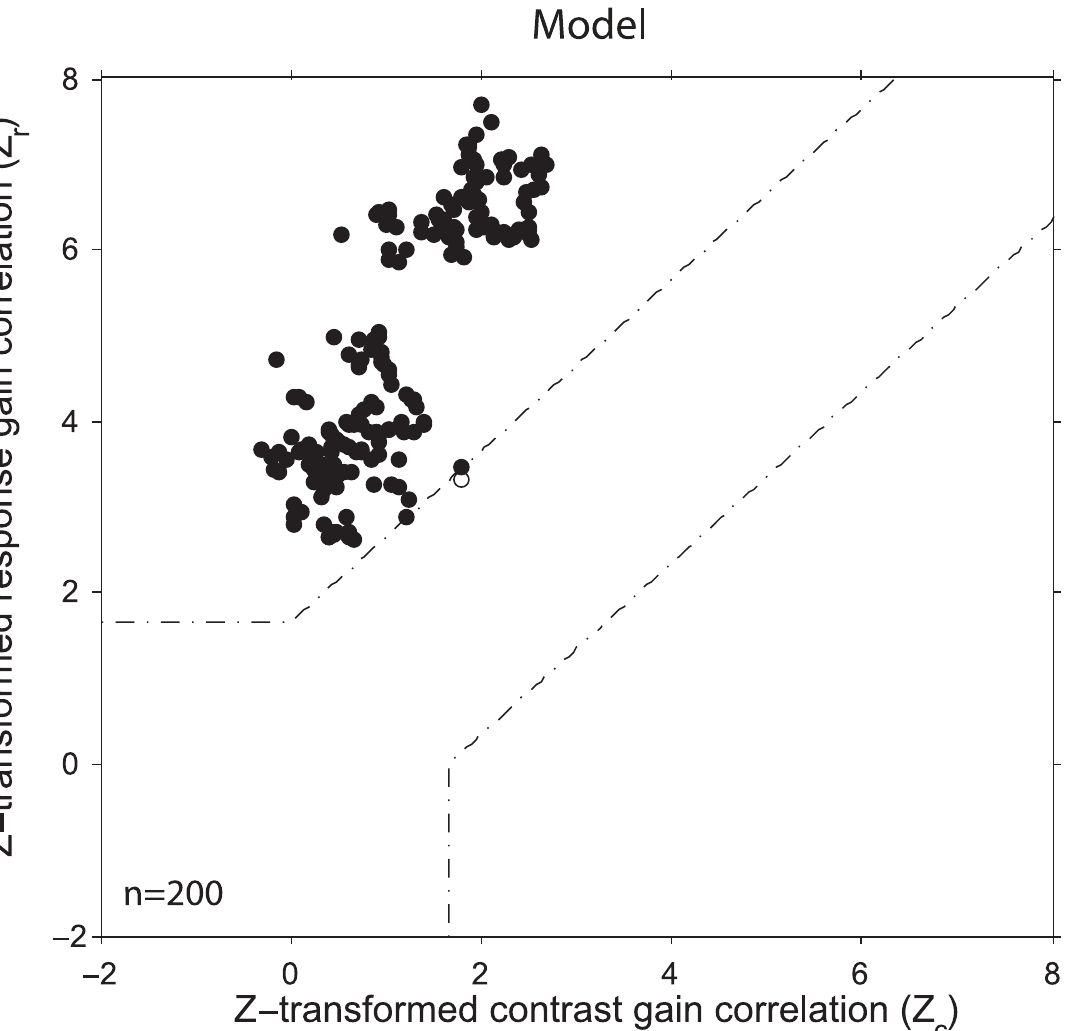
Figure 9. Z-transformed partial correlations between simulation data and curve fitting. Black circles are neurons having fits that are significantly better described by the response gain model. Dotted lines indicate the threshold for statistical significance. For the majority of neurons in both the model and experimental data (See Fig. 3A in [5]), the attentional effect on contrast-response functions is significantly better explained by response gain.